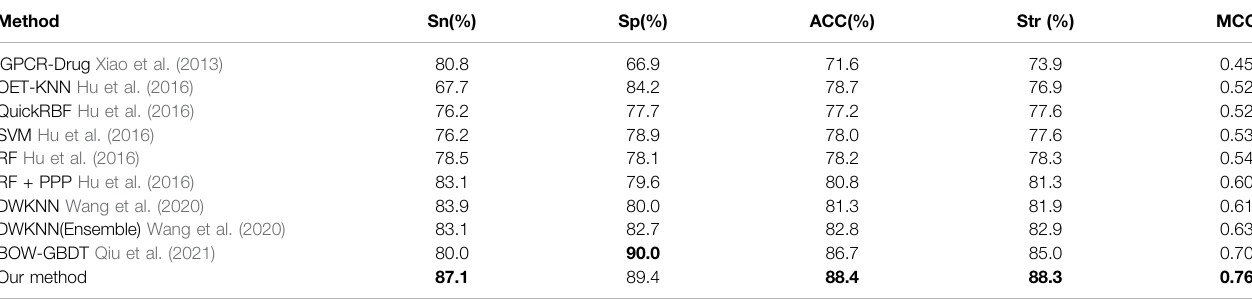
TABLE 4 | Performance comparison on